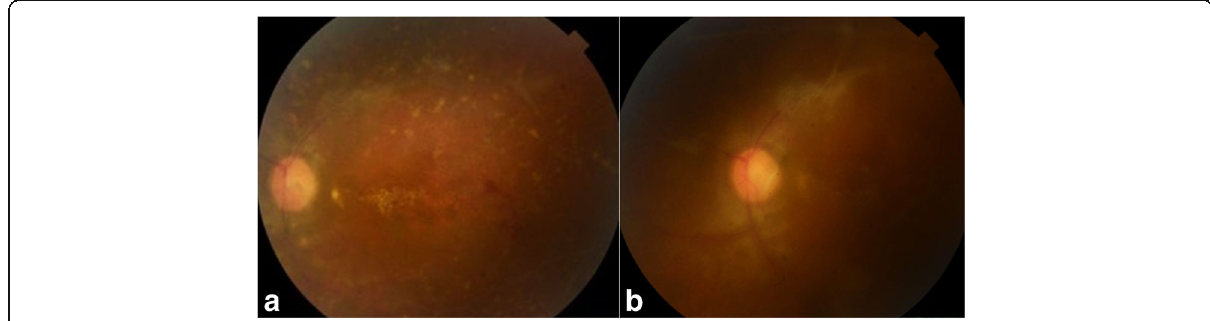
Fig. 6 A 23-year-old female patient presented with vision blurring in the left eye. Color fundus photograph shows numerous white retinal lesions, associated with diffuse venous sheathing and a few retinal hemorrhages ( a ). Serology was positive for syphilis. Color fundus photograph, 2 months after presentation, shows residual retinal pigment epithelial changes and venous sheathing ( b